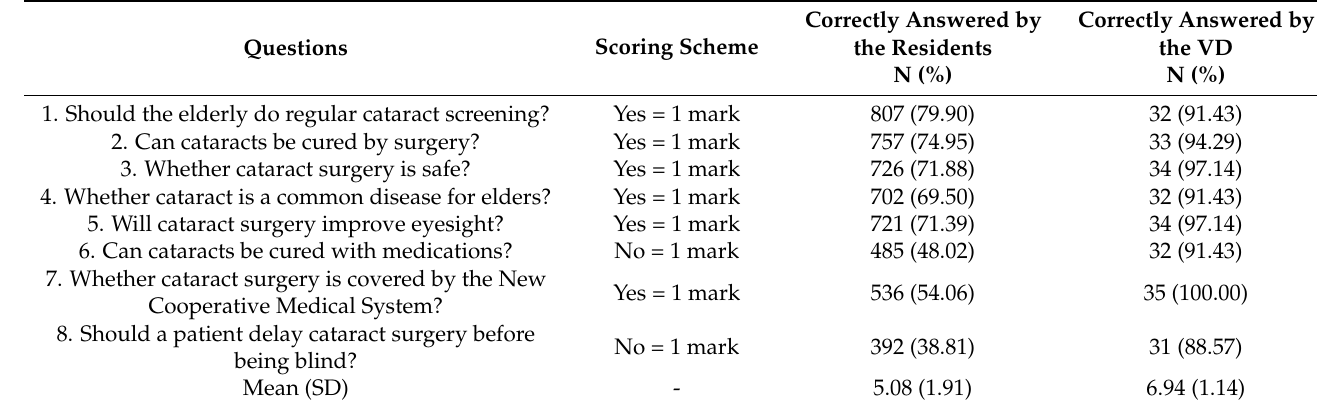
Table 2. Knowledge about cataract among residents ( n = 1010) and VDs ( n =